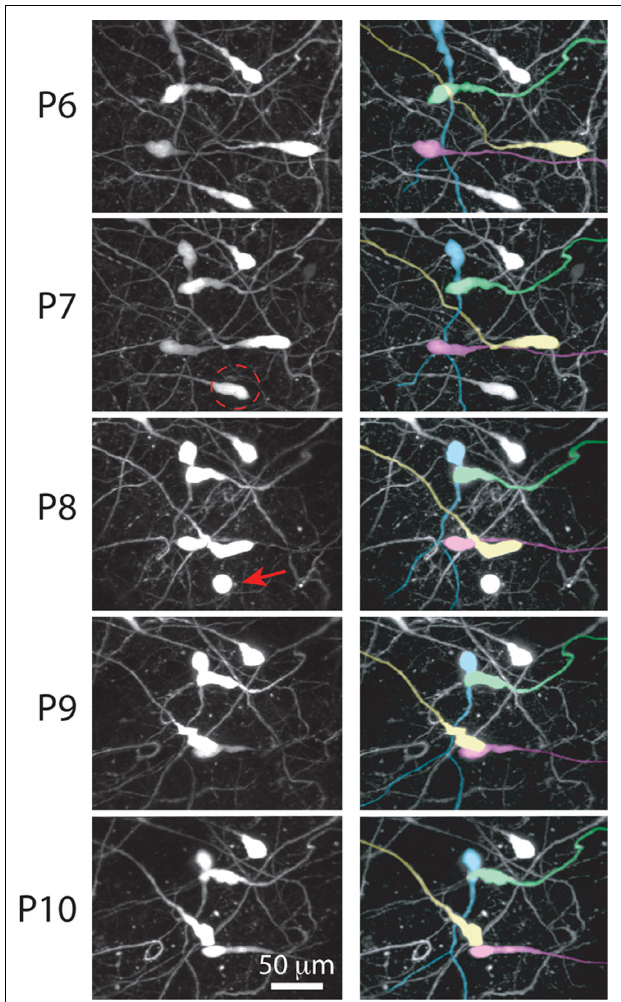
FIGURE 7 | Retraction of CR neuron somata during early postnatal development. Left: in vivo two-photon time-lapse imaging of CR neurons in an Ebf2-GFP mouse from P6 to P10. A neuron at P7 (dashed circle) is seen undergoing apoptosis at P8 (red arrow). Right: same image sequence, in which four individual CR neurons are color-coded, to help visualize the retraction of cell bodies. Some somata (e.g., yellow cell) retract > 100 µm.